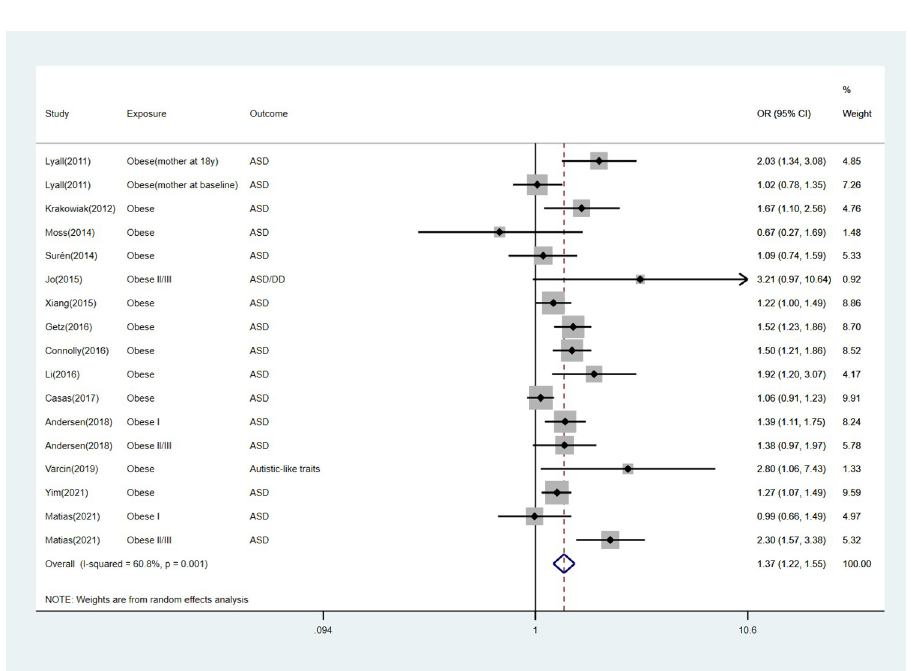
Fig 4. Forest plot for obese mothers and their offspring’s risk of ASD.